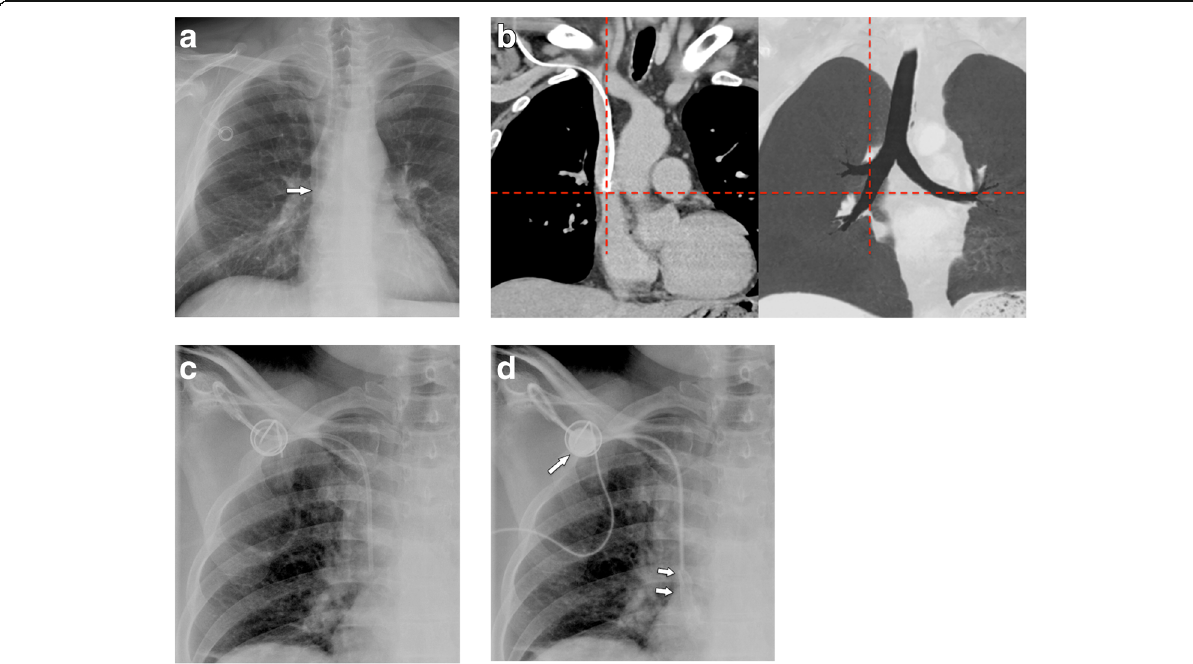
Fig. 1 Normal position of implanted port system. a Chest radiograph shows the tip of the venous catheter projecting onto the intersection with the intermediate bronchus, which suggests position in the SVC. b Coronal MDCT reformation (soft tissue window and minimum intensity projection of lung window) shows that intersection of the tip with intermediate bronchus indicates correct position in the SVC. c , d Flow confirmation study ( c ) before and ( d ) after injection of contrast. The port chamber is completely opacified (arrow), the venous tube does not show leakage, and contrast material exits freely at the tip flowing in antegrade direction (small